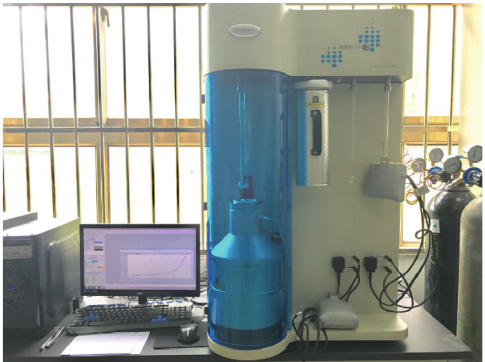
Figure 5: The chloride diffusion coefficient test. Table 6: The relationship between initial current and power-on time.